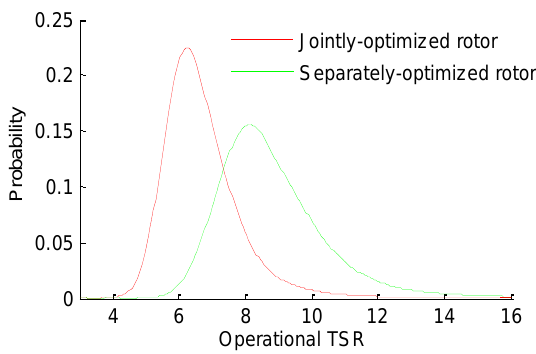
Figure 10. Probability distribution of operating TSR of the optimized rotors.